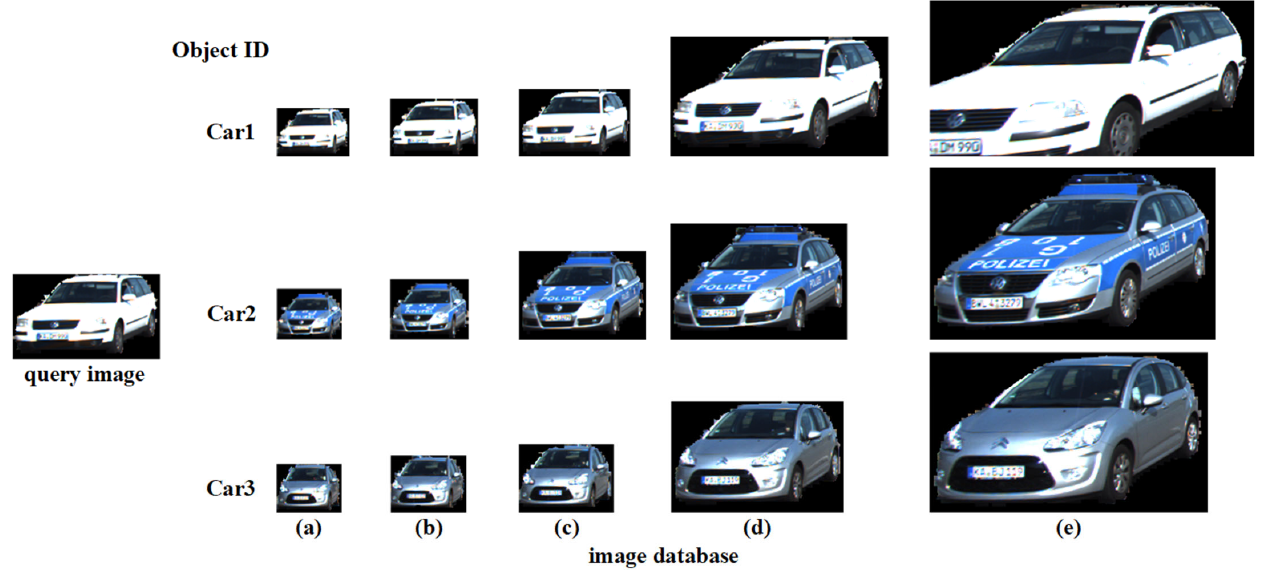
Figure 4. The query image and the image database. The query image is the same car as Car1, while Car2 and Car3 are cars that are different from the query image. In the image database, ( a – e ) represent the images of Car1, Car2, and Car3 in five different sizes, respectively.